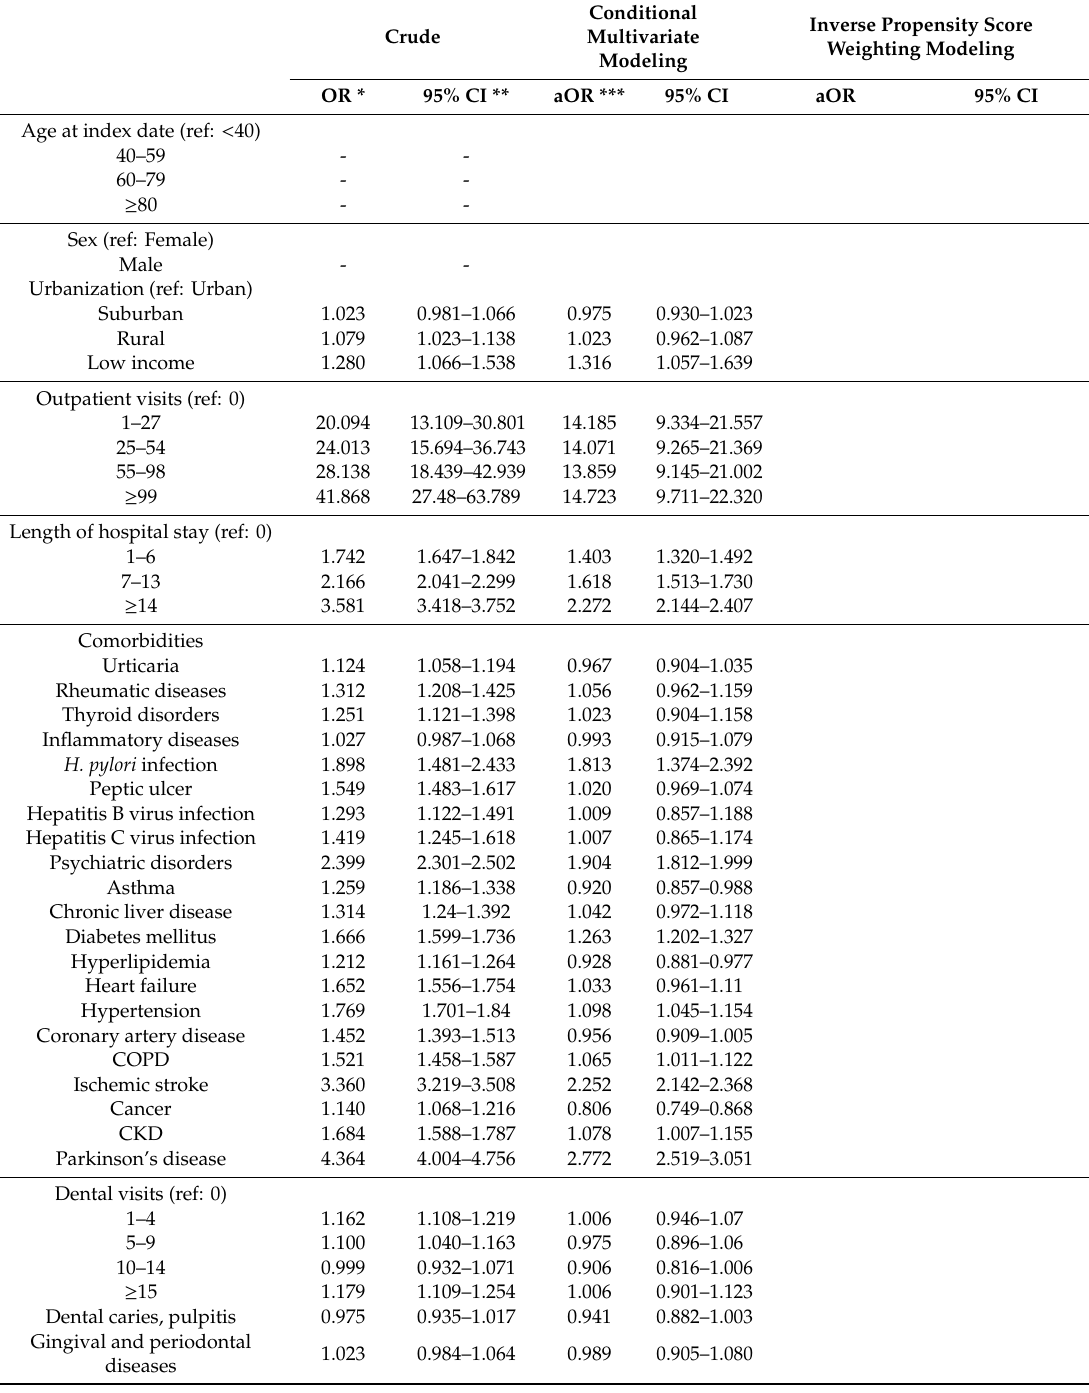
Table 2. Logistic regression for estimating the odds ratio of dementia. Conditional Crude Multivariate